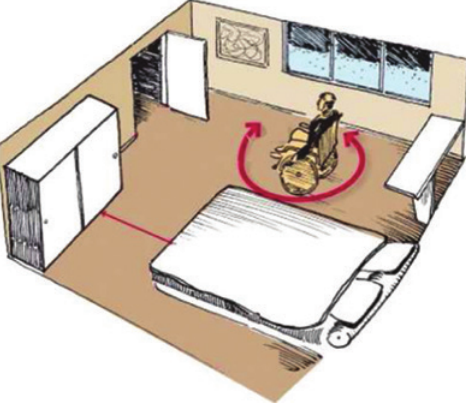
Figure 5: Example of Navigation Environment.